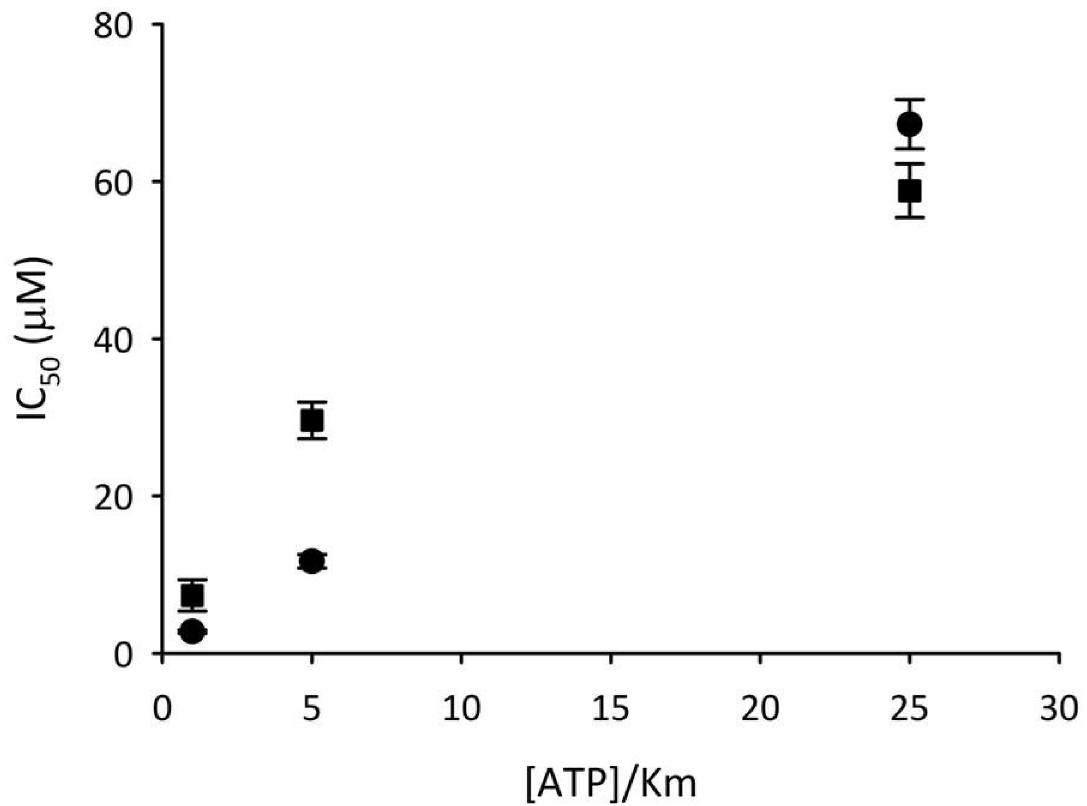
Fig 6. Analysis of the mechanism of inhibition of PPIP5K by UNC10112646 and UNC10225498. Assays were performed in HTS format with 2-fold serial dilutionsfrom 100 μ M of either UNC10112646 (squares) and UNC10225498 (circles) and varying concentrations of ATP as indicated. Data represent means and standard errors from 3 experiments. The mean Ki values for inhibitionof PPIP5K by UNC10225498and UNC10112646 were 2.0 ± 0.6 μ M and 3.6 ± 1.3 μ M, respectively. In these experiments, the uninhibitedPPIP5K activity is equivalent to consumption of 18.9 ± 0.9% of the